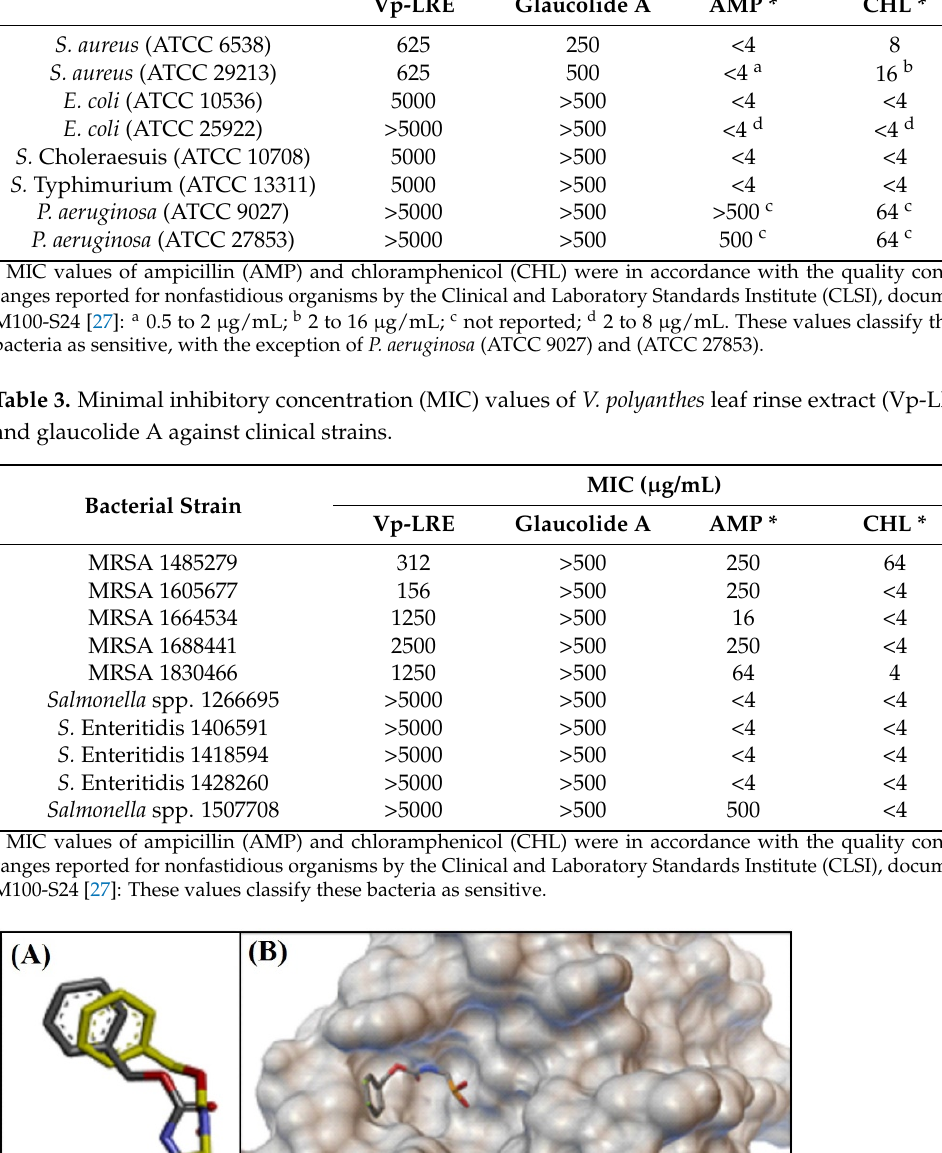
Table 4. Free energy values of ligands.